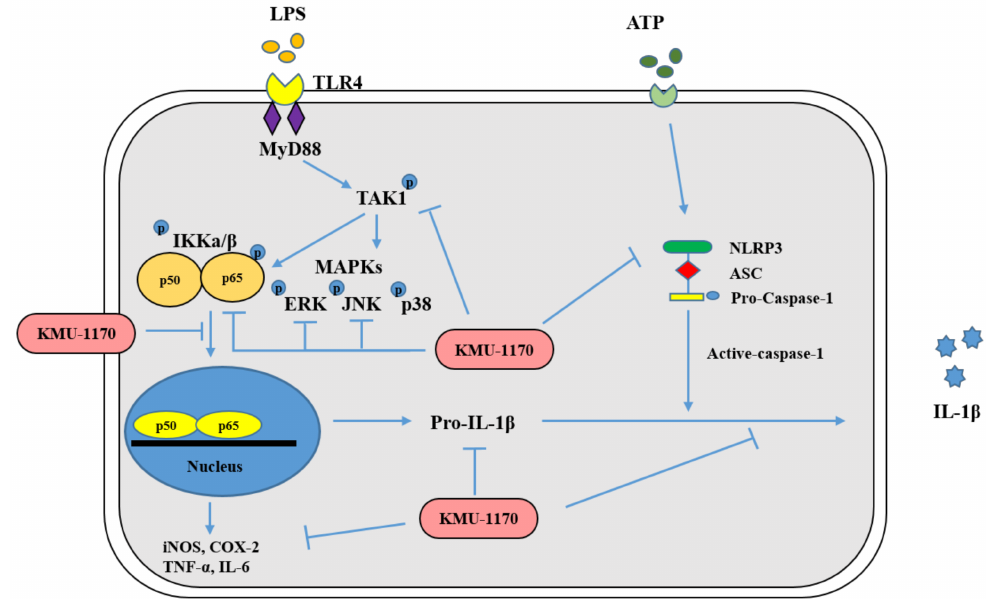
Figure 7. Mechanistic scheme summarizing the anti-inflammatory effect of KMU-1170. LPS, lipopolysaccharide; TLR4, toll-like receptor 4; MyD88, myeloid differentiation factor 88; TAK1, transforming growth factor- β -activated kinase 1; IKK, inhibitor NF- κ B kinase; MAPKs, mitogen-activated protein kinases; NF- κ B, nuclear factor- κ B; iNOS, inducible nitric oxide synthase; COX-2, cyclooxygenase-2; TNF- α , tumor necrosis factor- α ; IL-1 β , interleukin-1 β ; NLRP3, NOD-like receptor family, pyrin domain containing 3; ASC, apoptosis-associated speck-like protein containing a